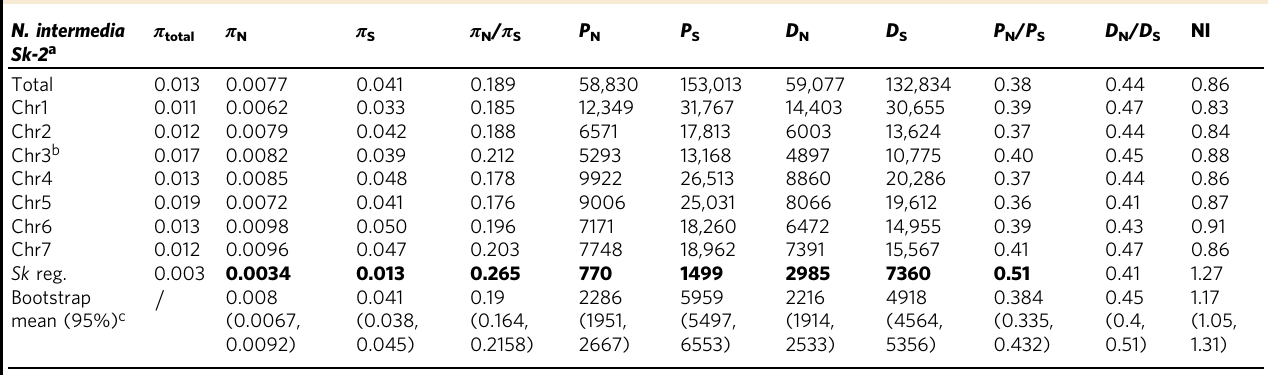
Table 3 Nucleotide diversity and divergence of two N. intermedia Sk-2 strains N. intermedia Sk-2